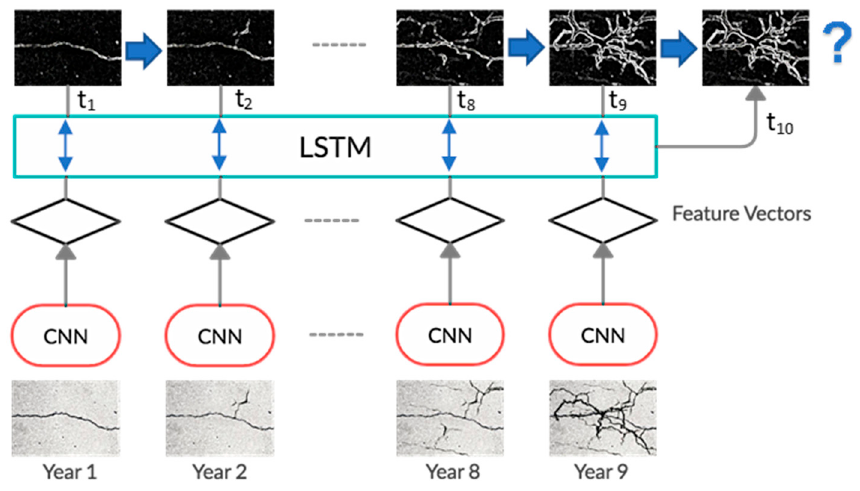
Figure 10. CNN–LSTM model for time history prediction of future damage condition.